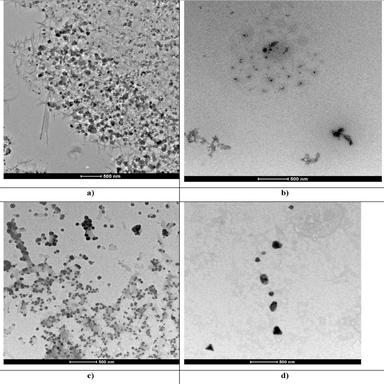
TEM micrographs of 1st fraction of PPPs eluted by AF4-FFF-MALS: a) CS; b) EC; c) OD; d) WP.